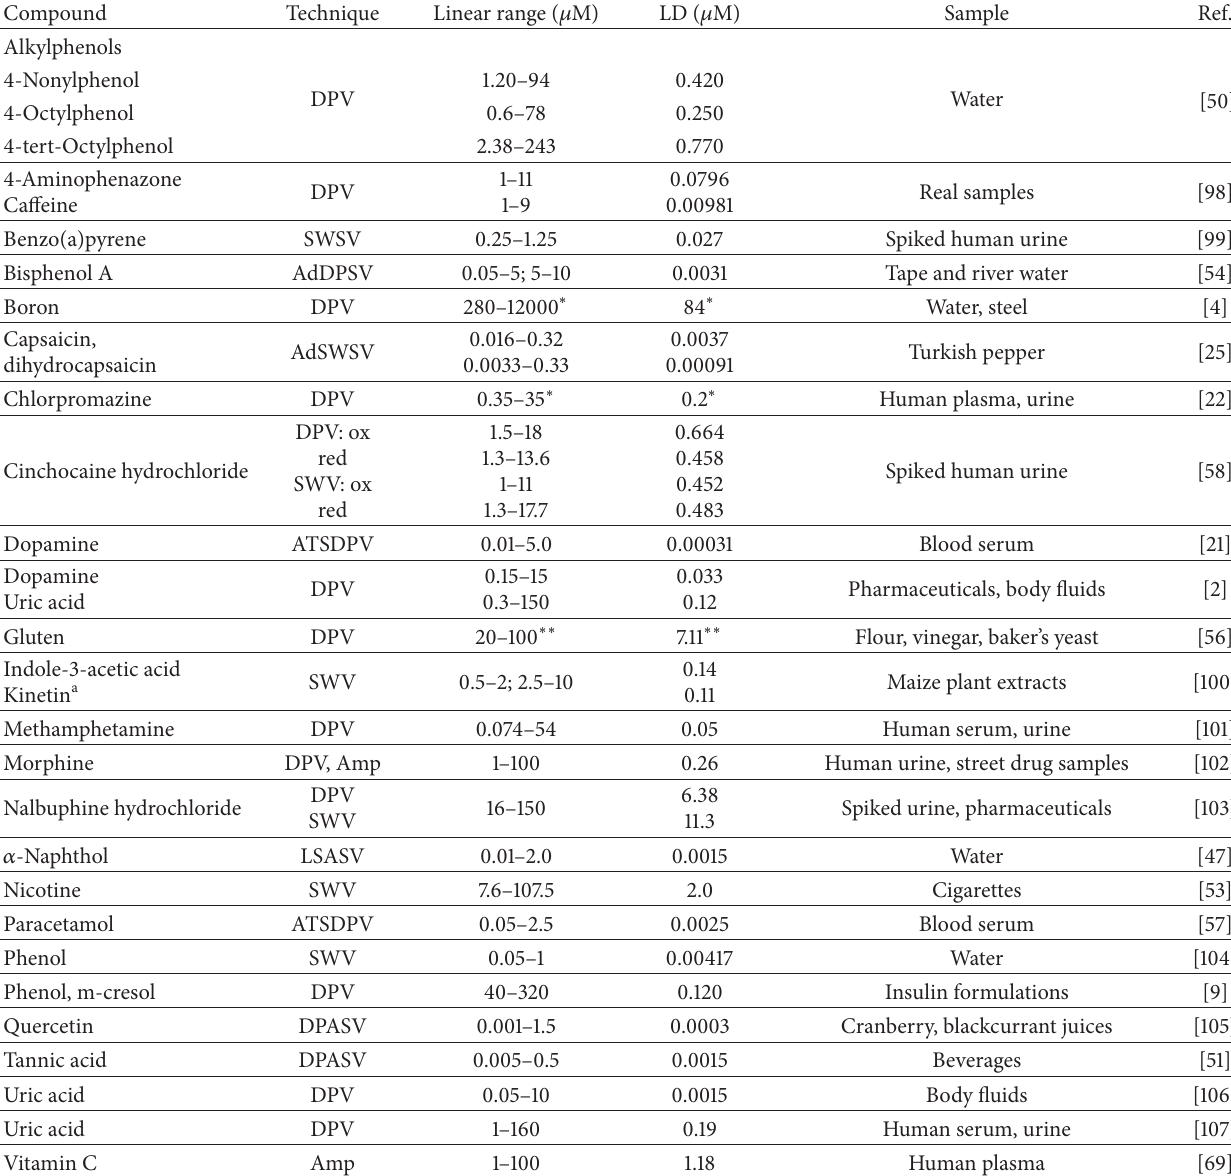
Table 2: Electroanalytical applications of